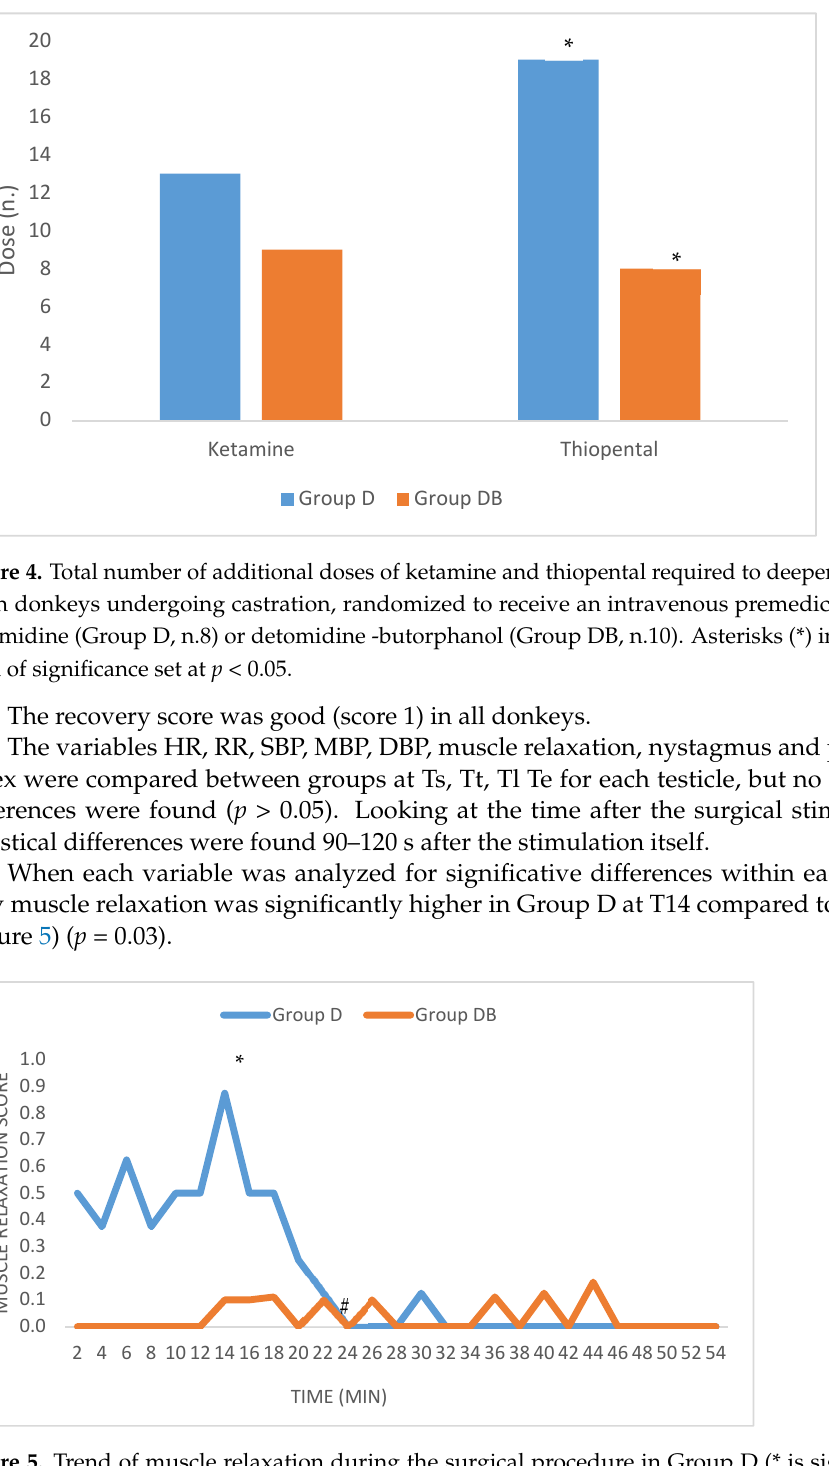
Figure 5. Trend of muscle relaxation during the surgical procedure in Group D (* is significantly higher than #; p = 0.03).